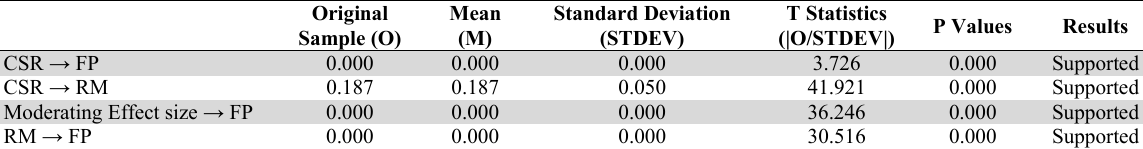
Hypothesis test results